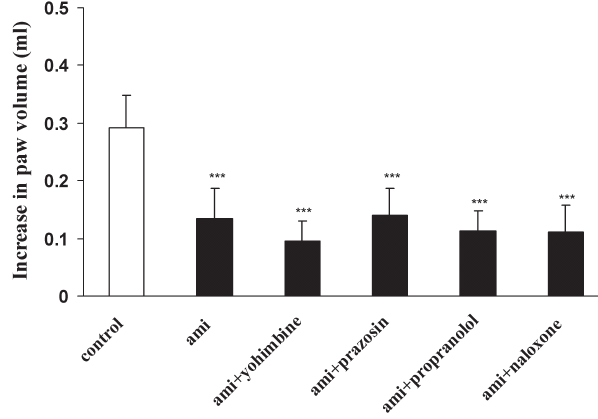
Figure 4 - Effect of pretreatment with yohimbine (10 mg kg -1 ), prazosin (4 mg kg -1 ) and propranolol (10 mg kg -1 ) on the anti- The values represent the mean variation in the paw volume ¡ S.D. (n=6, *** P , 0.001). ami: